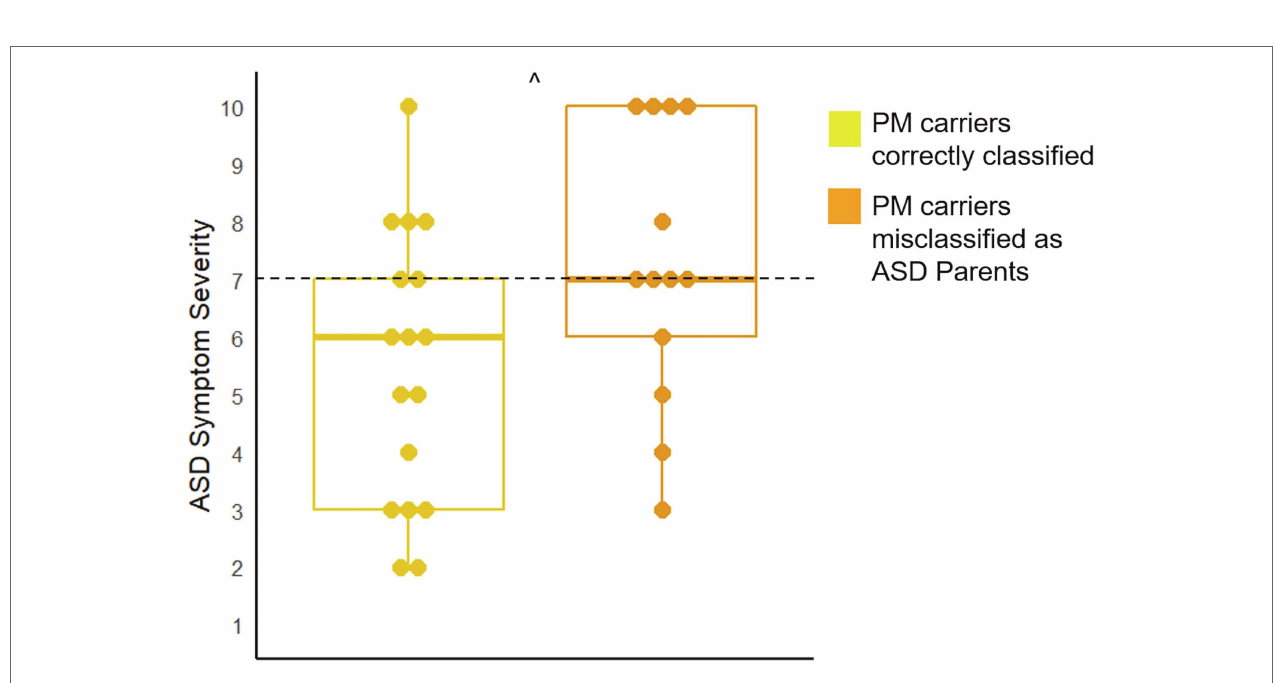
FIGURE 4 | Comparison of ASD symptom severity as measured by the ADOS-2 in the children of PM carriers who were misclassified as ASD parents and those who were correctly classified ( ^ p < 0.10). The cut-off for meeting criteria for ASD is seven (range: